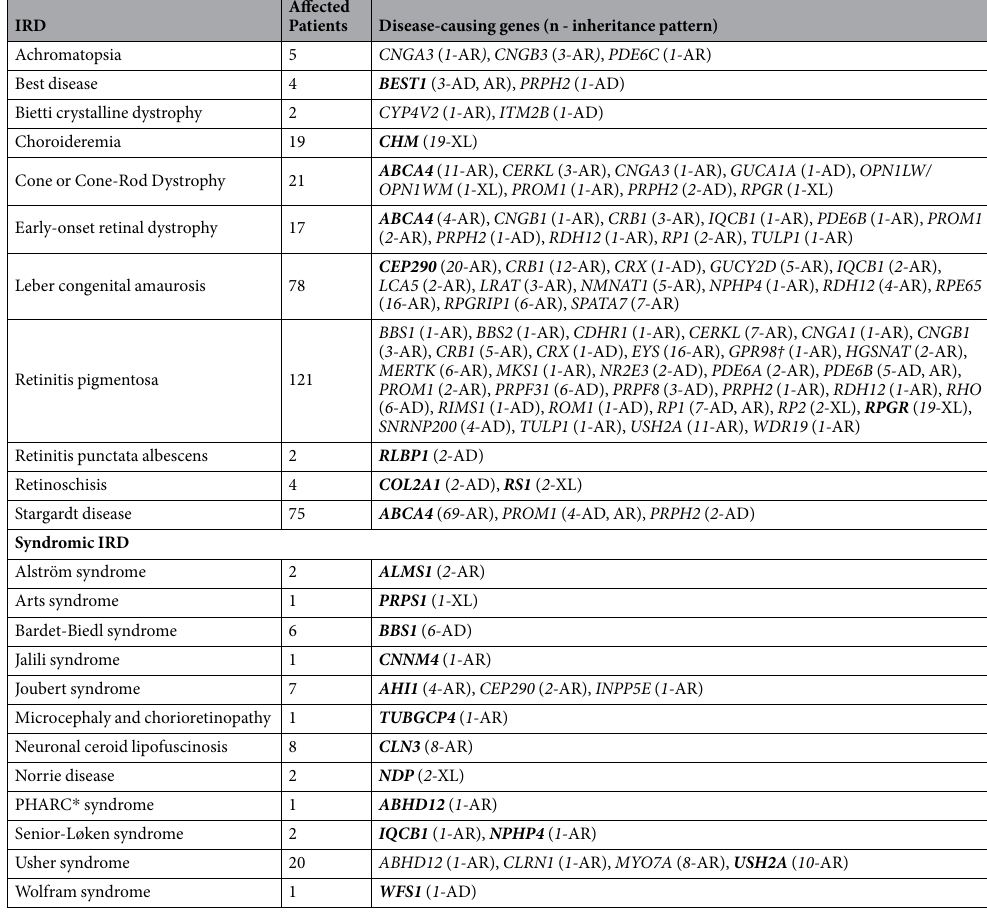
Table 2. Number of affected patients with positive genetic testing per retinopathy. The boldface type indicates the most frequent disease-causing genes. The total number of patients affected by non-syndromic IRD is 348 and by syndromic IRD 52. AD: autosomal dominant; AR: autosomal recessive; XL: X-linked inheritance. * PHARC: Polyneuropathy, Hearing loss, Ataxia, Retinitis pigmentosa and Cataract. † Also known as